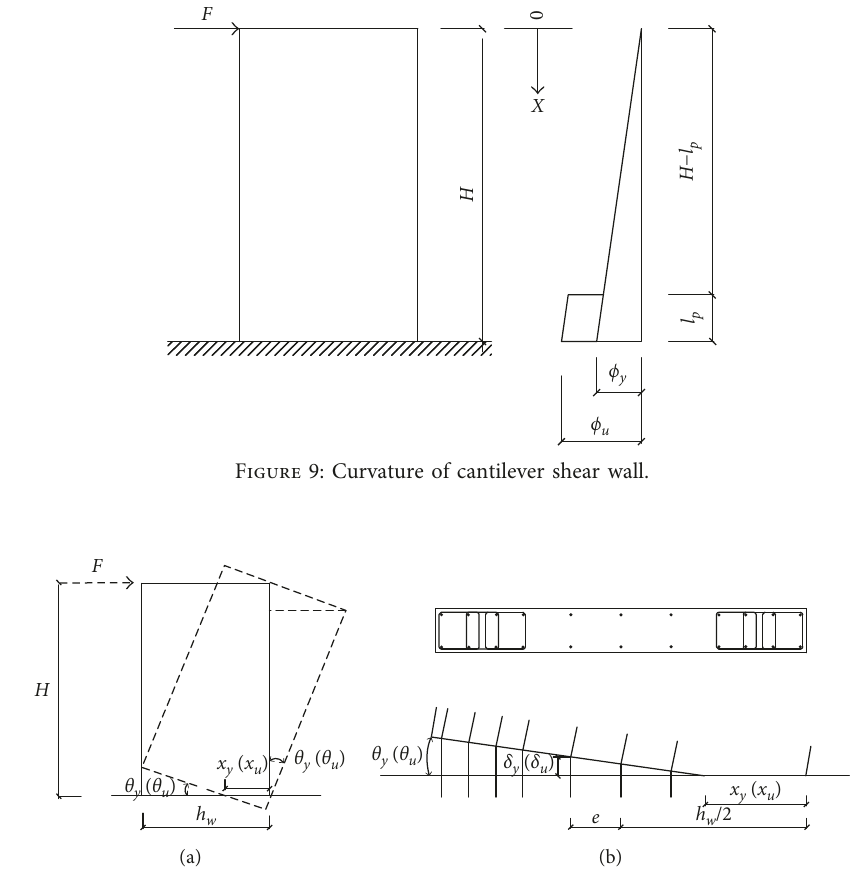
Figure 10: (a) Rigid body rotation and (b) unbonded reinforcement deformation of RHC shear wall.